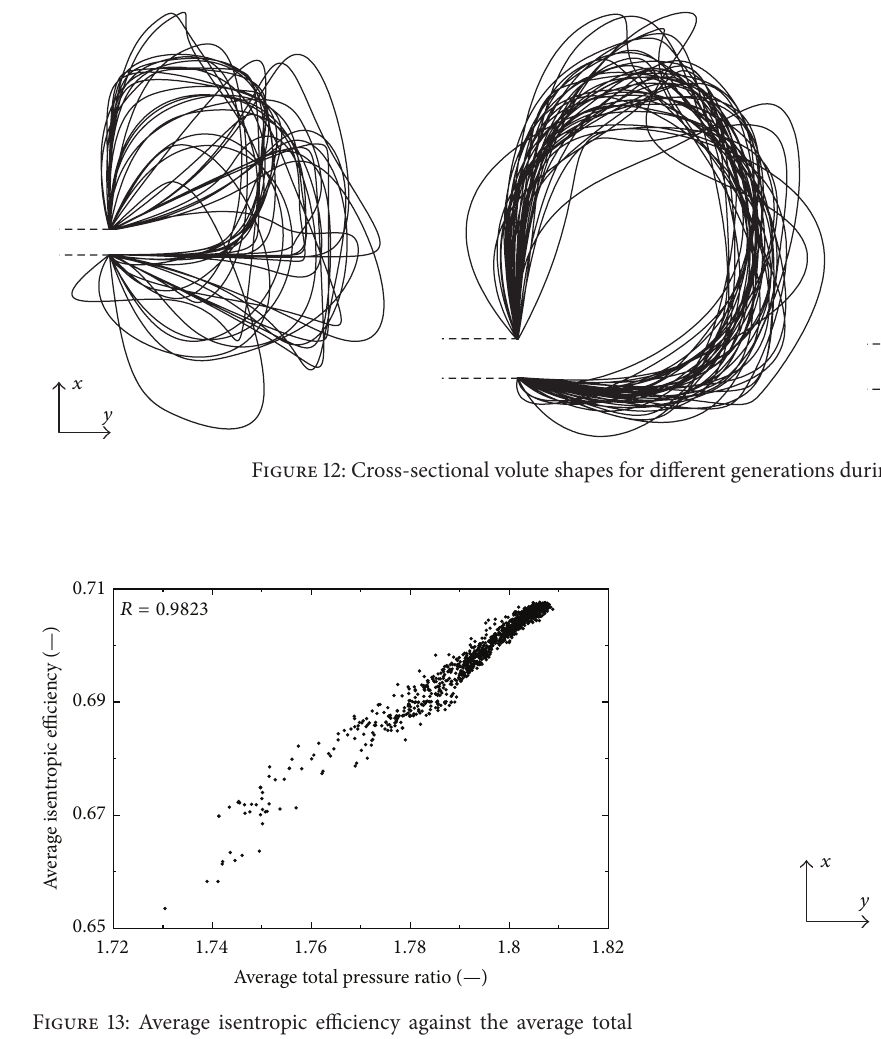
Figure 13: Average isentropic efficiency against the average total pressure ratio for different individuals. The correlation coefficient 𝑟 is nearly one which indicates a linear correlation.